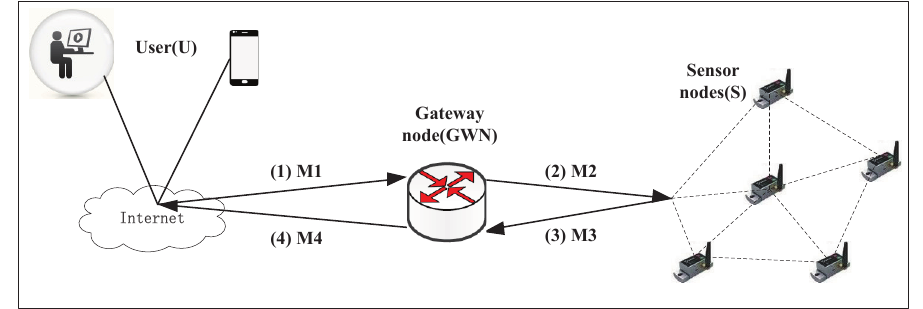
Figure 1. Communication model of the proposed